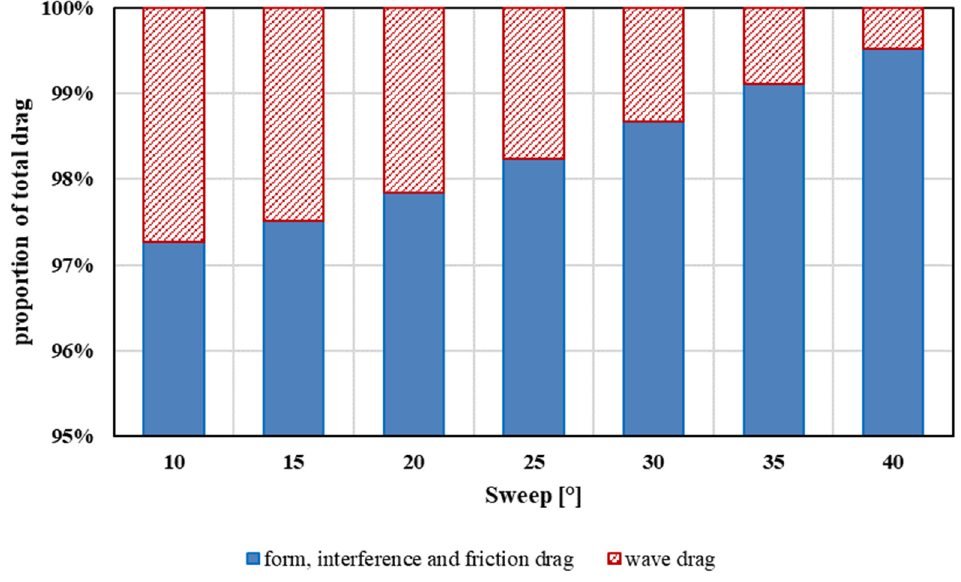
Figure 11. M MRC and range for variable sweep angle Λ for both models, with and without C Dw .